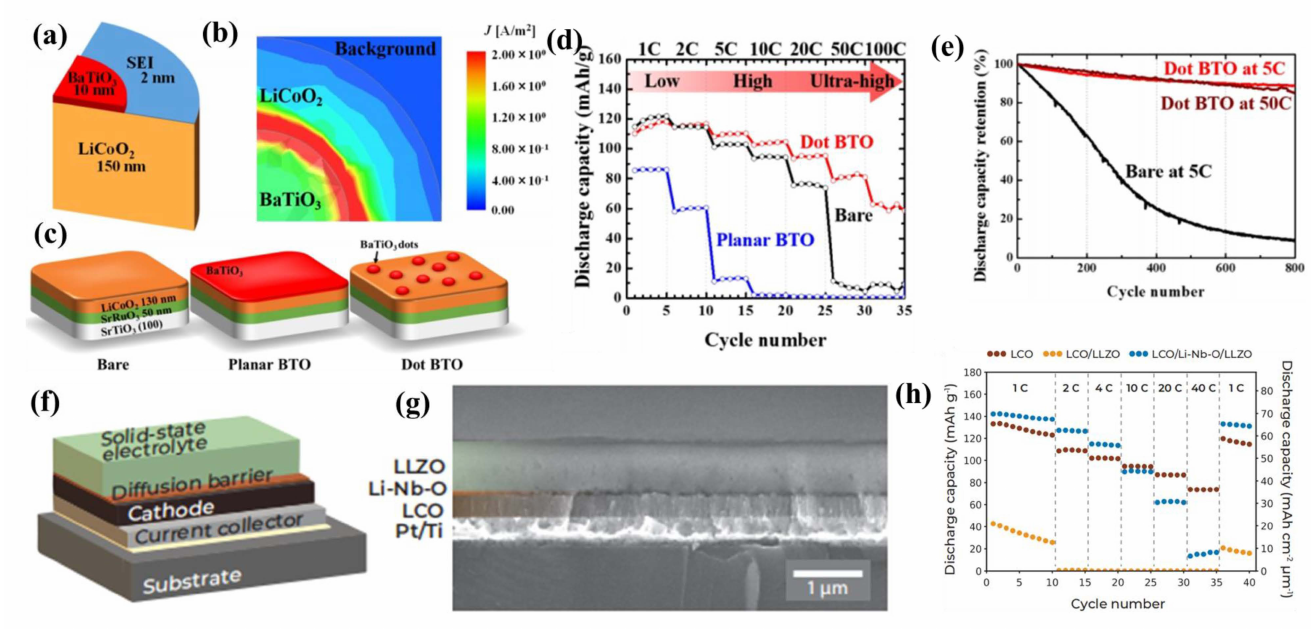
Figure 5. ( a ) Schematic of the calculated model structure of BTO-LCO with ANSYS HFSS. ( b ) Calcu- lated current density mapping on an LCO surface. ( c ) Schematic three-dimensional images of Bare, Planar BTO, and Dot BTO. ( d ) Discharge capacities as a function of C − rate, which increases from low 1 C to ultra-high 100 C in a five − repeated measurement sequence for each C − rate. Black, blue, and red circles correspond to Bare, Planar BTO, and Dot BTO, respectively. ( e ) Discharge capacities of Bare at 5 C, Dot BTO at 5 C, and Dot BTO at 50 C repeating 800 times. Reprinted with permission from Ref. [113]. Copyright 2019, American Chemical Society. ( f ) Schematic of the thin film solid electrolyte/thin film cathode architecture investigated. ( g ) Cross − section SEM image of the thin-film half − cell stack (Si/MgO/Ti/Pt/LCO/Li-Nb-O/LLZO). ( h ) Discharge capacities at different C − rates (1 C, 2 C, 4 C, 10 C, 20 C, 40 C) of the LCO, LCO/LLZO, and LCO/Li − Nb − O/LLZO half-cell stacks. Reprinted with permission from Ref. [116]. Copyright 2020, American Chemical